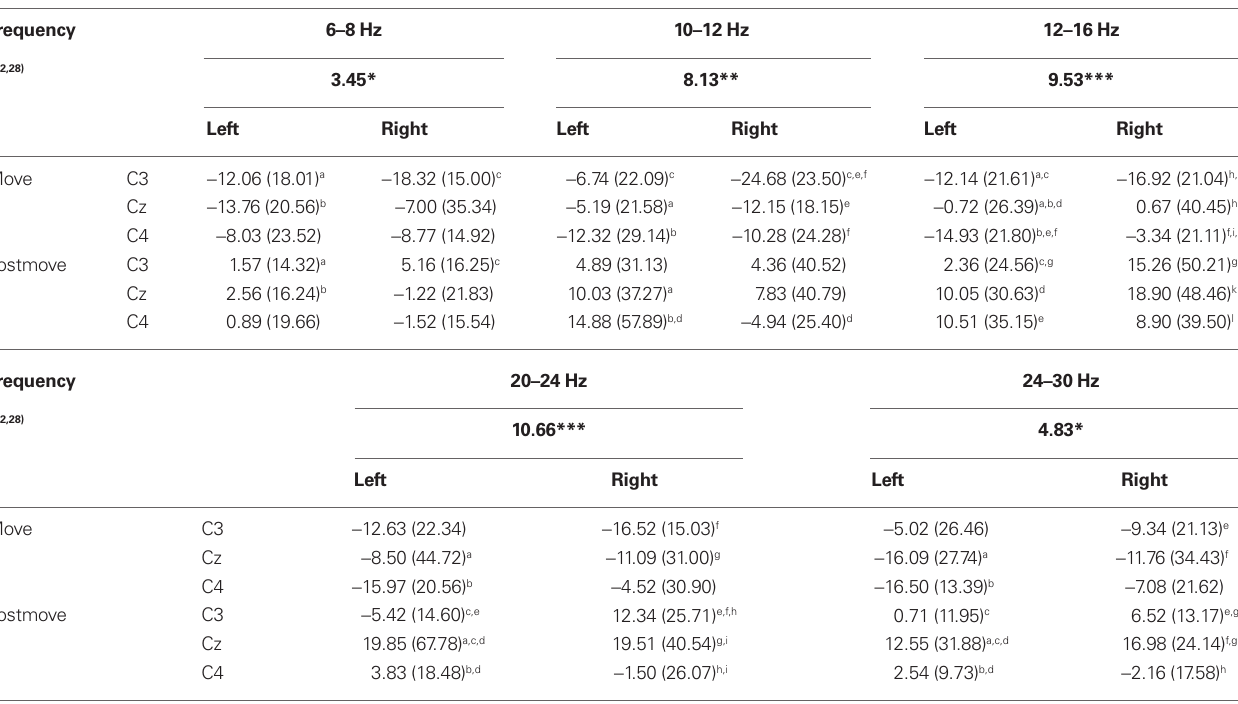
Table 5 | F -values, mean, and SD of erD/erS values for the significant interaction “hand × phase × position” in motor imagery task.